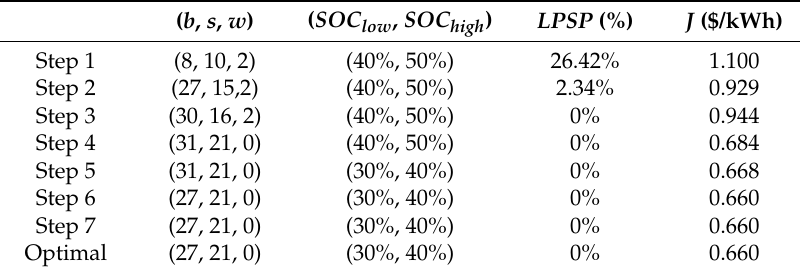
Figure 7. The reference plots for the lab load. Table 6. The optimal design procedures for the lab load.